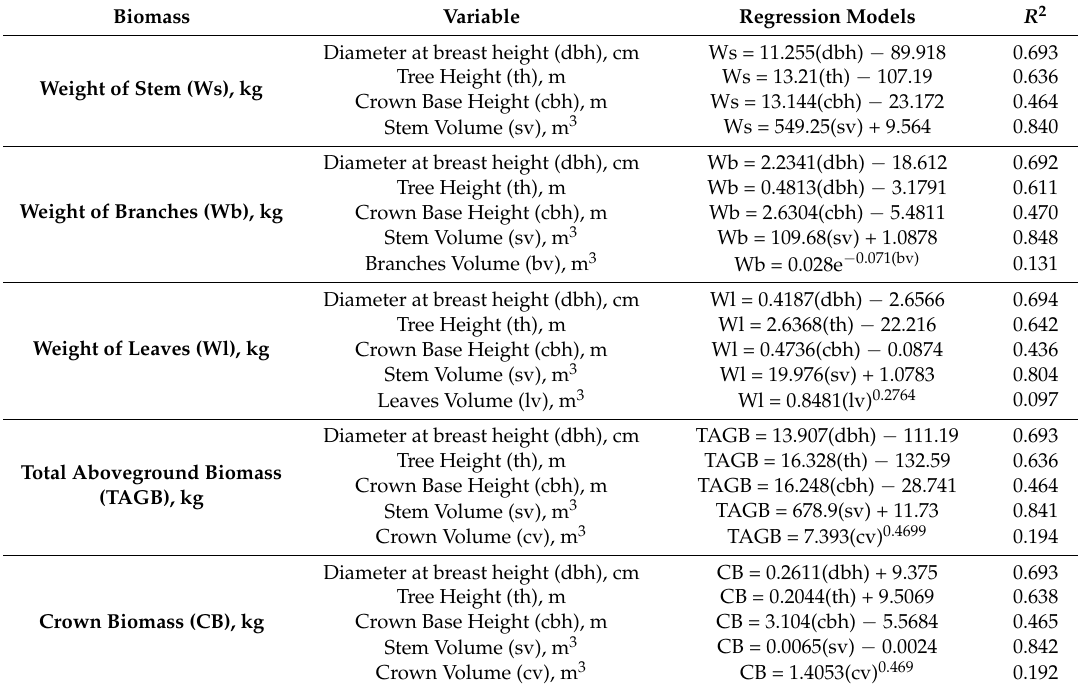
Table A2. Allometric equation generated for Balik Angin with tree variables obtained from TLS. Biomass Variable